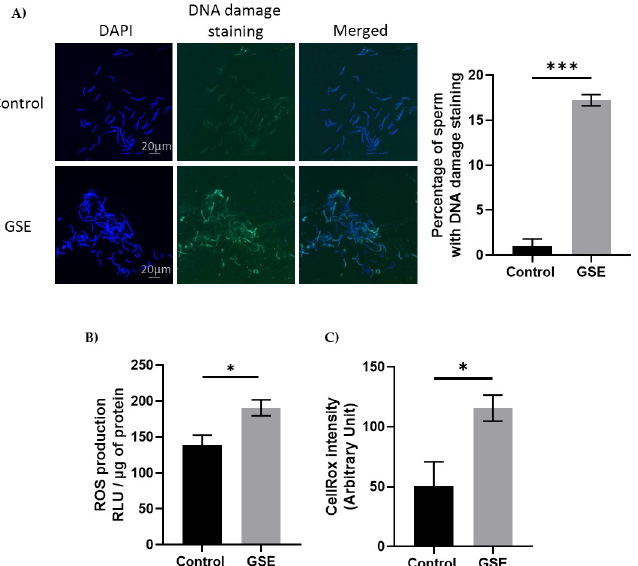
Fig 4. Marker of sperm quality. (A ) Representative picture of DNA damage staining on spermatozoa from control or F1-GSE group (200 spermatozoa/animal with n = 5 animals per group) ( B ) Level of Reactive Oxygen Species (ROS, H 2 0 2 ) in spermatozoa (n = 7 per group) and (C) quantification of oxidative stress staining was analysed by CellROX staining. Intensity was quantified using ImageJ (Arbitrary units) (200 spermatozoa/animal with n = 5 animals per group). Results are presented as means ± SEM. � , p < 0.05. ��� , p <